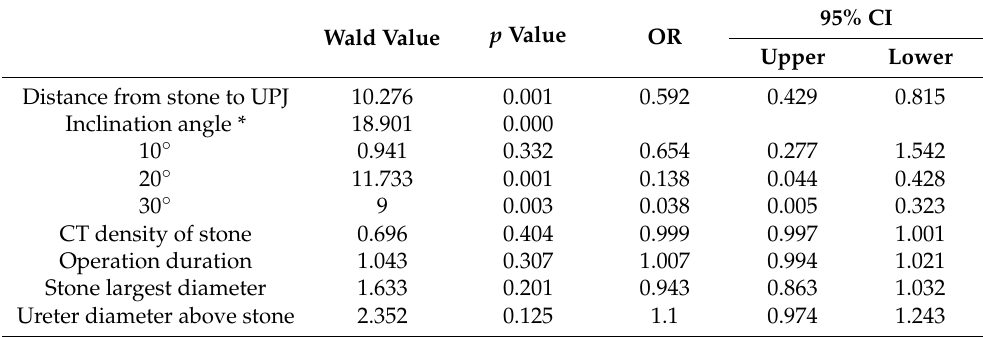
Table 3. Logistic regression analysis of related factors for stone-free rates one month after